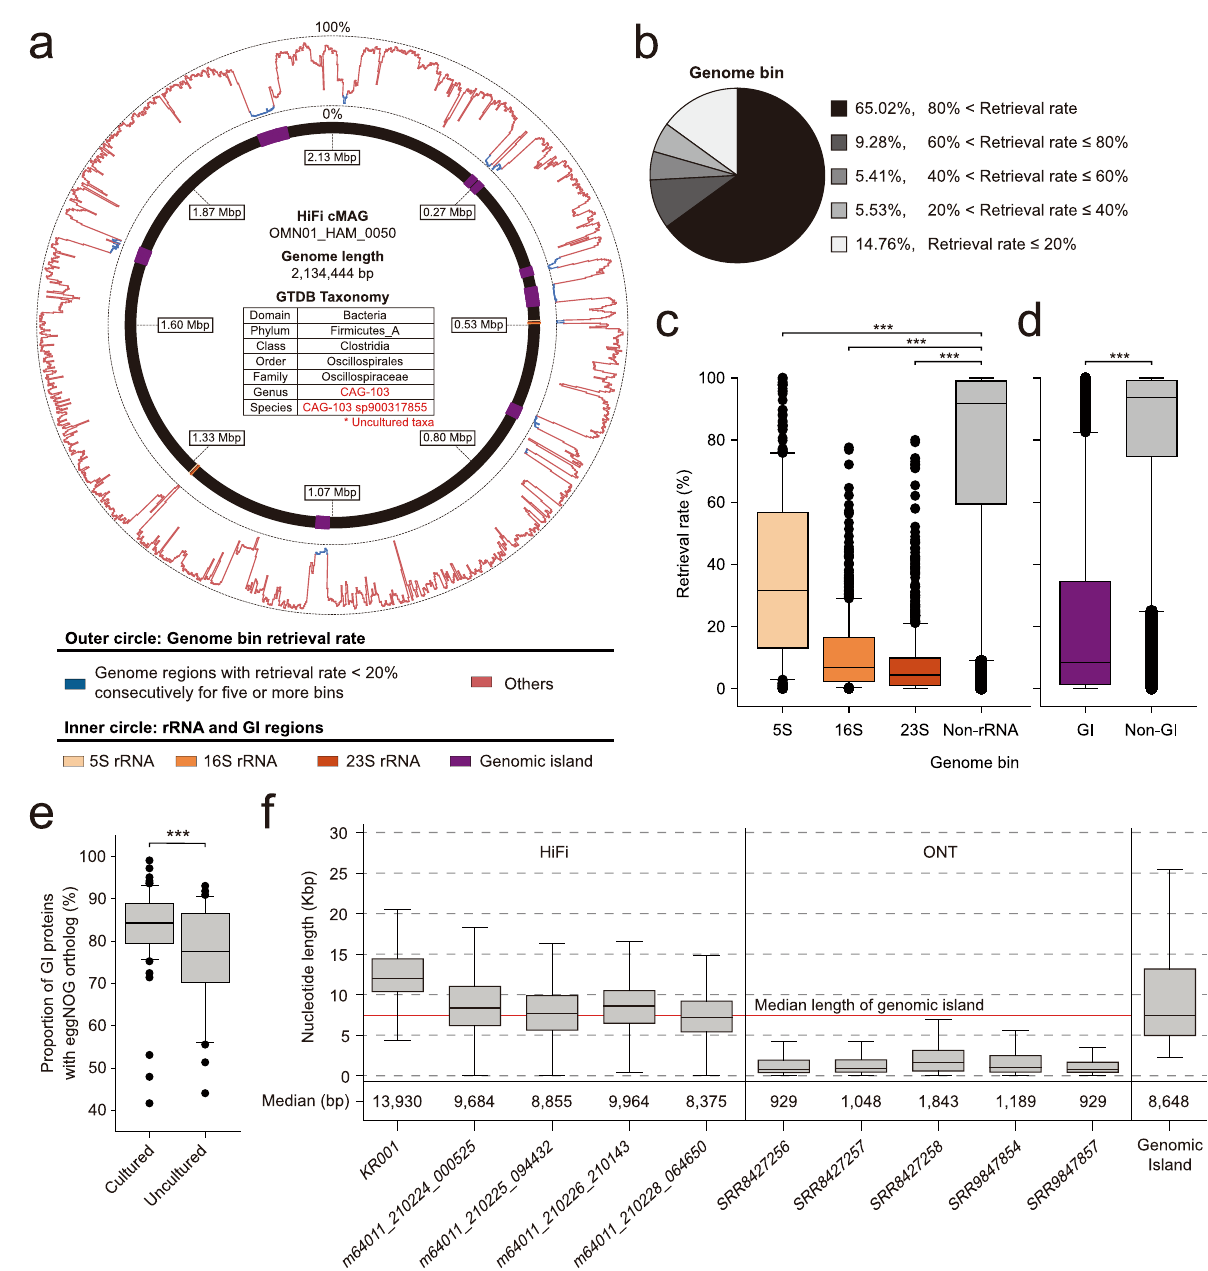
Fig. 4 | HiFi-assembled cMAGsretrieve hard-to-assembleregions by short-read assembly.a GenomebinretrievalrateandgenomeregionannotationplotofacMAG for the uncultured species OMN01_HAM_0050. The inner circle annotates rRNA and genomic island regions. The outer circle represents retrieval rate by conspeci fi c HRGM MAGs for every 1-kbp genome bin. b Proportion of genome bins by retrieval rate. c , d Retrieval rate of genome bins that include rRNAs ( c ) or genome islands ( d ) ( n =393for5SrRNAgenome bins, n =662for16SrRNAgenome bins, n =1258for23S rRNA genome bins n =283,267 for non-rRNA genome bins, n =30,330 for GI genome bins, and n =255,146 for non-GI genome bins). Retrieval rate was compared by the two-sidedMann – Whitney U test.( P -value=1.83e − 97for5SrRNA, P -value=6.39e − 286 for 16S rRNA, P -value<1e − 300 for 23S rRNA compared to non-rRNA genome bins; P -value<1e − 300forGIgenomebinscomparedtonon-GIgenomebins). e Proportion of genomeisland proteins withan eggNOG ortholog accordingtothe cultured status